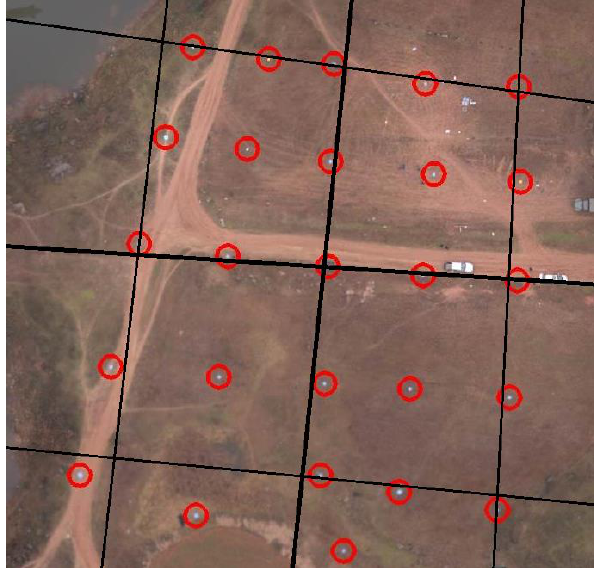
Figure 2. Control points and flight route for camera